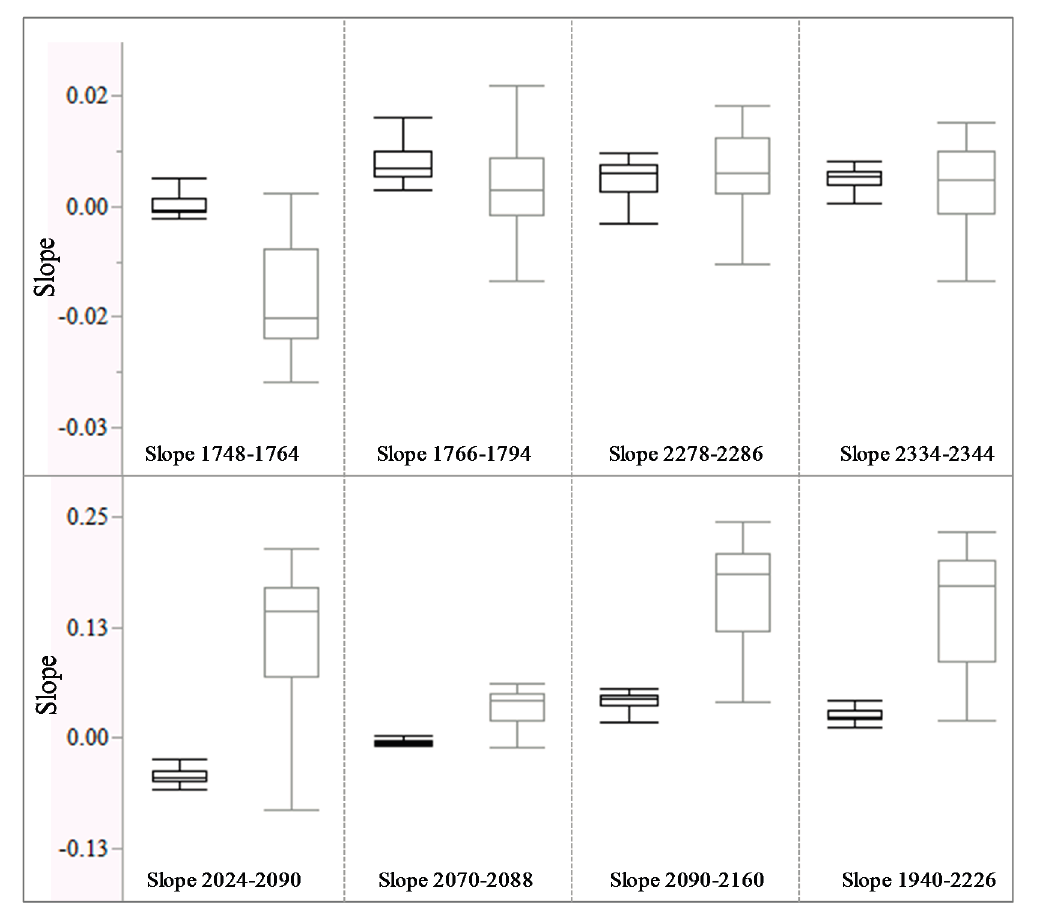
Figure 4. Slope value distribution of dry (black) and fresh (gray) vegetation for 8 spectral